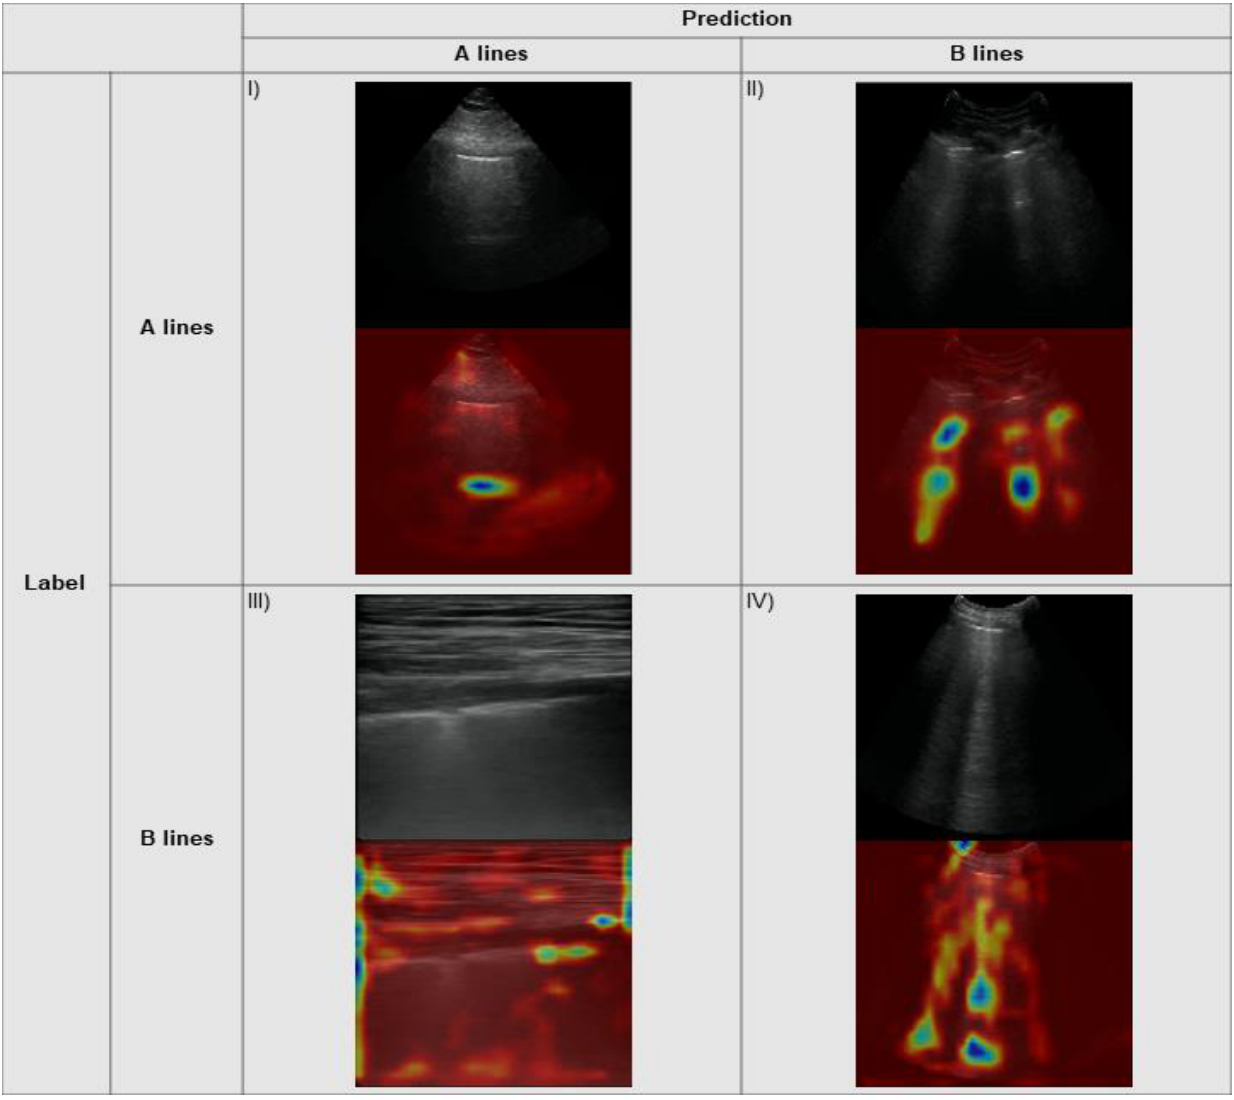
Figure 8. Grad-CAM heatmaps overlying example frames from the Ottawa data: ( I ) Correctly predicted A line frame with a prediction probability of 0.95; ( II ) A line frame incorrectly predicted as a B line frame with a prediction probability of 0.99 for B line; ( III ) B line frame incorrectly predicted as an A line frame with a prediction probability of 0.75 for A line; ( IV ) Correctly predicted B line frame with a prediction probability of 1.00.